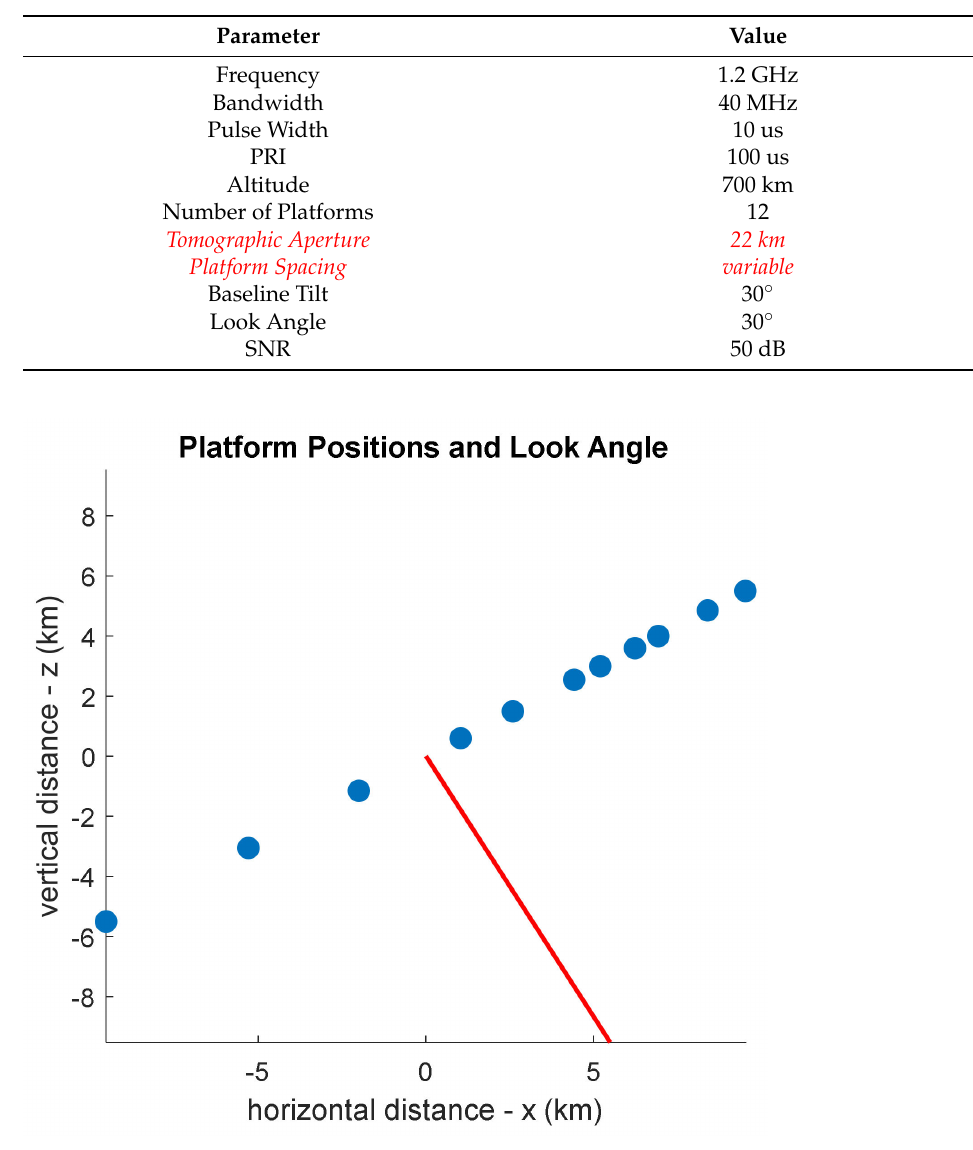
Figure 33. The observation geometry for Example 9. Blue dots represent the platform locations and the red line represents the look